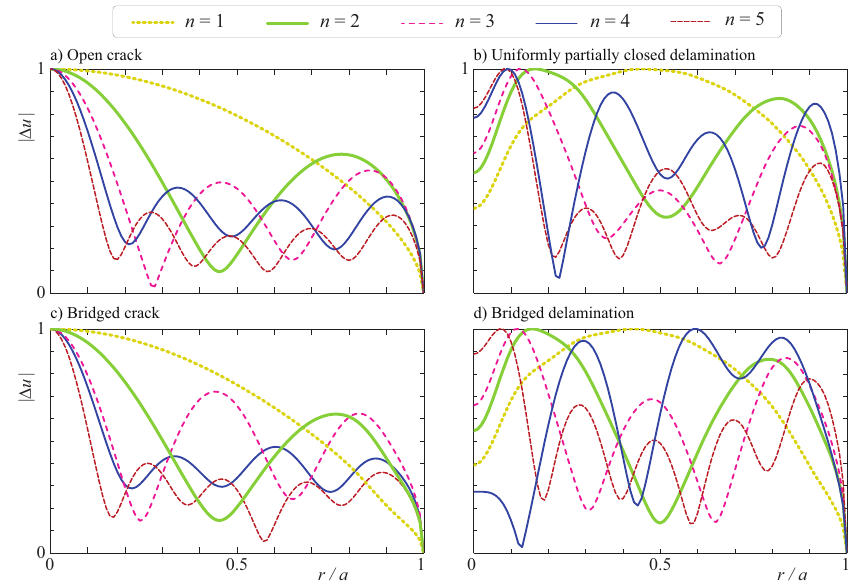
Figure 11. The amplitudes of the non-zero components of the COD | ∆ u | corresponding to the resonance regimes of motion at the eigenfrequencies ˆ k 0 n for interface delaminations of four kinds: two half-spaces are made of aluminium and